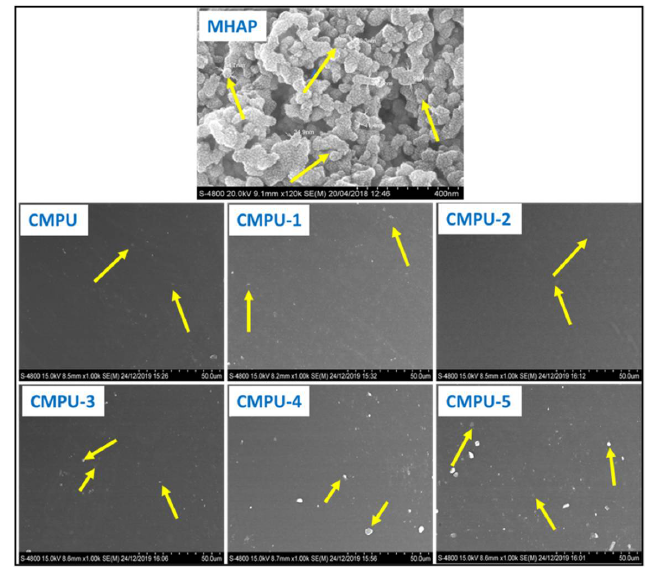
Figure 13. SEM images of MHAP, CMPU, CMPU-1, CMPU-2, CMPU-3, CMPU-4, and CMPU-5 coated samples.